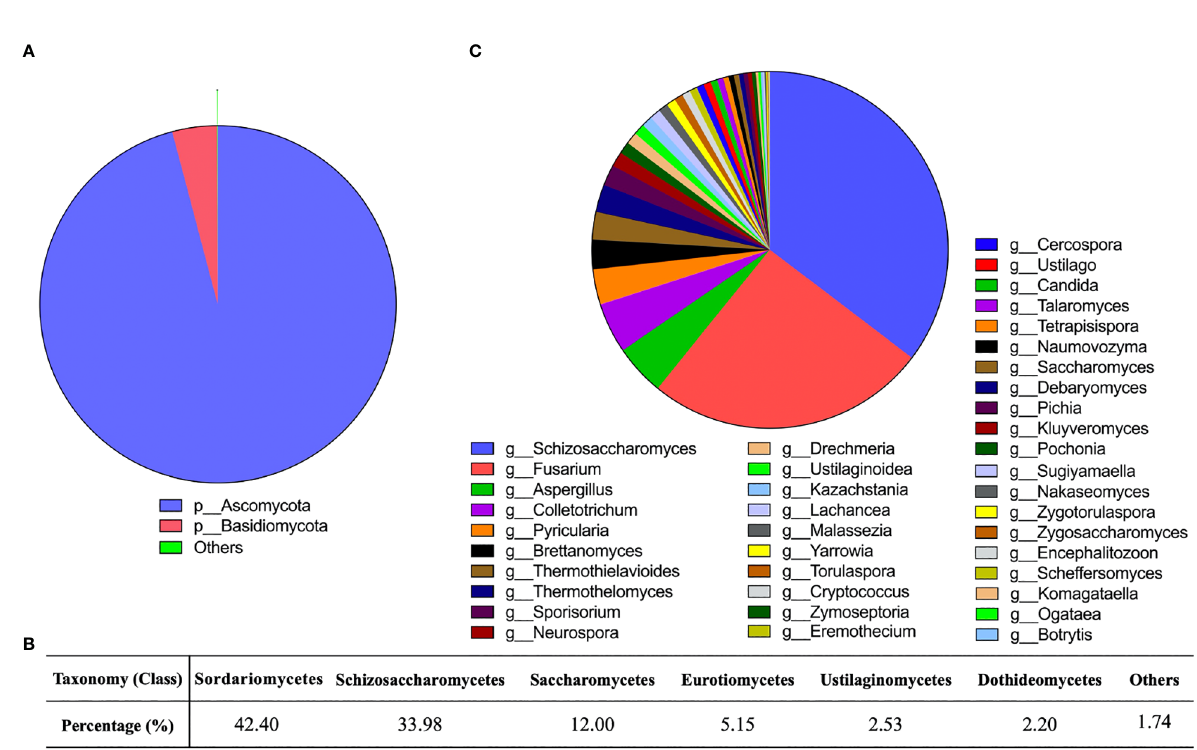
FIGURE 1 Gut fungal community in the donors. (A) Sector diagram showed the overall fungal community structure at the phylum level. (B) The percentage of different fungi at the class level. (C) Sector diagram showed the composition of the fungal